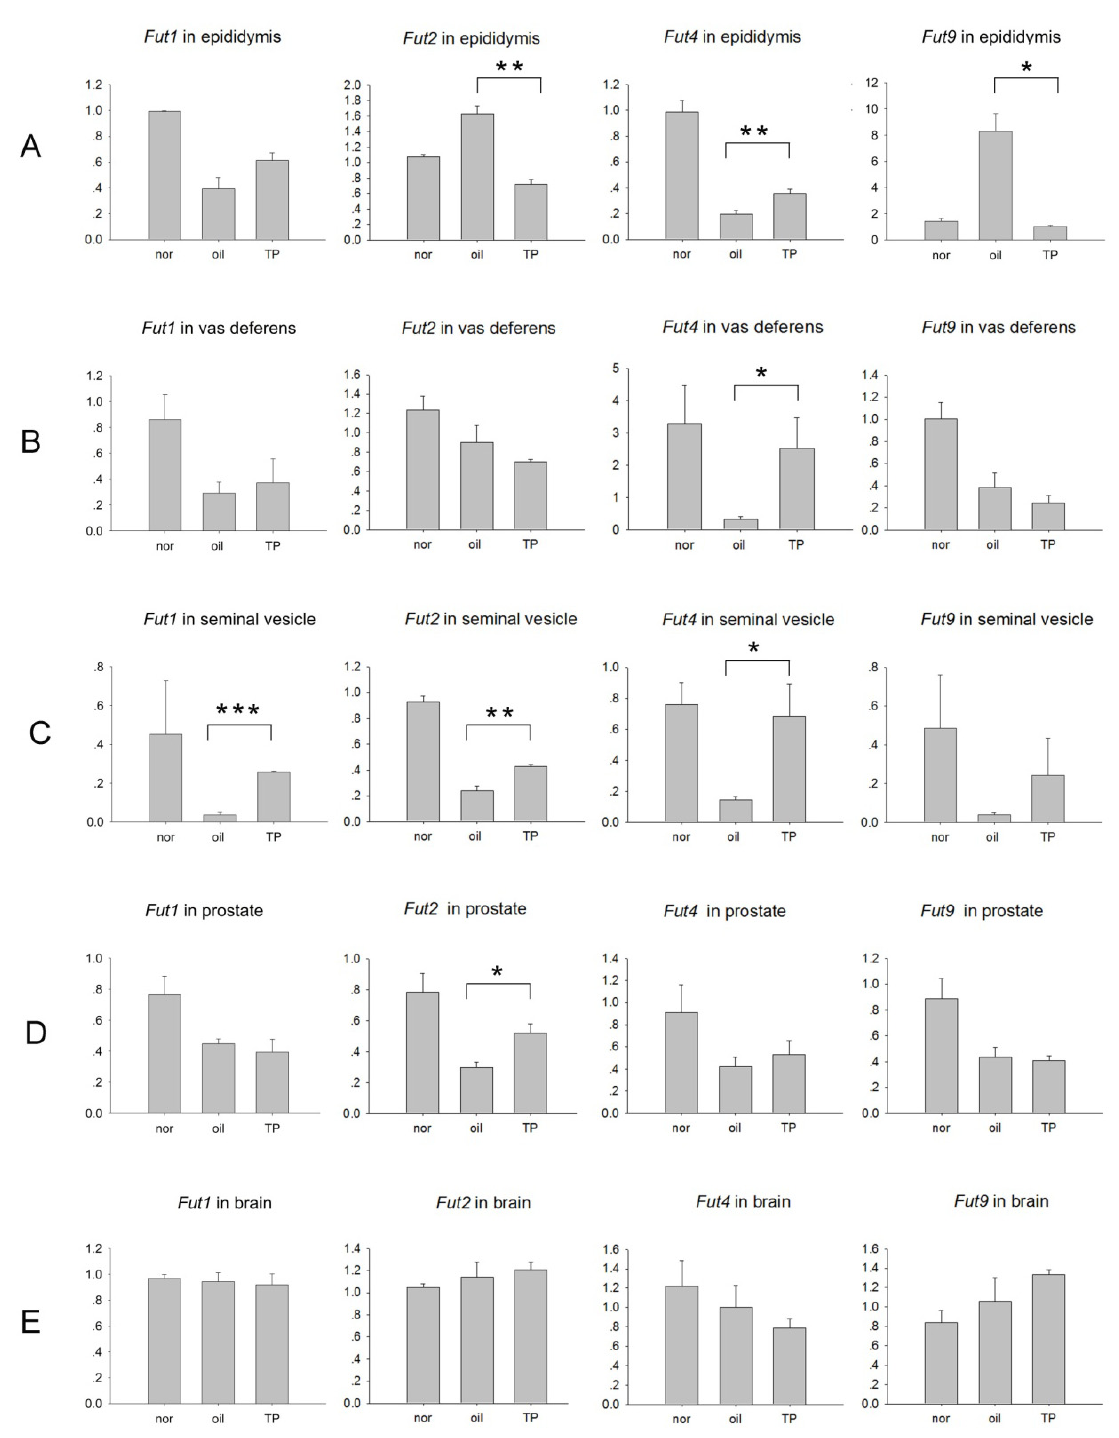
Figure 2. The expression of Fut1 , Fut2 , Fut4 and Fut9 in ( A ) epididymis; ( B ) vas deferens; ( C ) seminal vesicle; ( D ) prostate and ( E ) brain from animals in the “7 days castration + 2 days androgen replacement” castration model. Nor: normal non-surgery control; oil: oil vector control; TP: testosterone propionate replacement. Y -axis: mRNA expression of indicated genes using glyceraldehyde phosphate dehydrogenase (GAPDH) as the internal control. Data are expressed as the means ± SEM ( n = 3). * p < 0.05; ** p < 0.01; *** p < 0.001, as compared with the corresponding oil-treated castrated